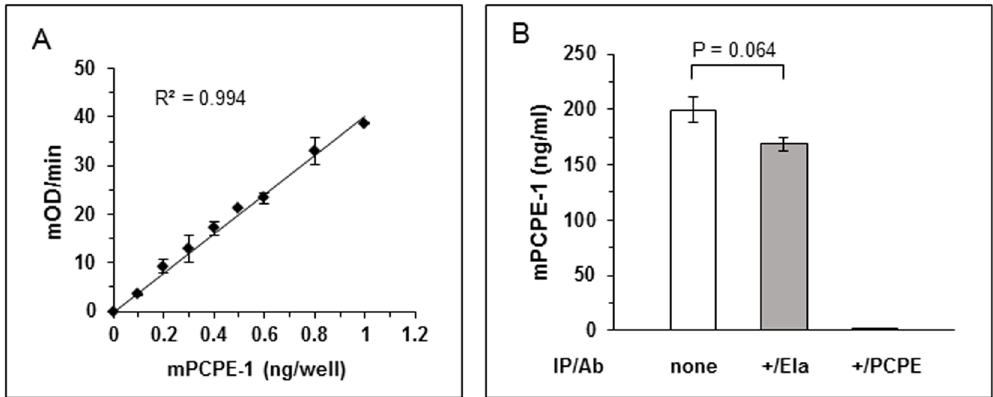
Fig 1. Sandwich ELISA for quantification of mPCPE-1. (A) Standard curve. Increasing amounts of purified mPCPE-1 were adsorbed to wells pre-coated with a rat monoclonal antibody to mPCPE-1. Bound mPCPE-1 was detected using a goat antibody to mPCPE-1 and quantified using an APA-conjugated rabbit anti goat IgG antibody. Each value represents mean ± standard deviation (SD); n = 2. mOD, Optical Density expressed in milli units; R 2 , coefficient of determination. (B) The ELISA is specific and permits determination of PCPE-1 concentration in mouse plasma. Plasma samples from a six weeks old C57/BL/6 mouse were subjected to IP with either goat antibody to mPCPE-1 (black) or a rabbit antibody to Pseudomonas elastase (negative control; grey). PCPE-1 concentrations in untreated plasma (white) and in plasma samples that underwent IP were determined using the sandwich ELISA. Values are mean ± SD (n = 4). Results are from a representative experiment out of two. IP , immunoprecipitation; Ab ,